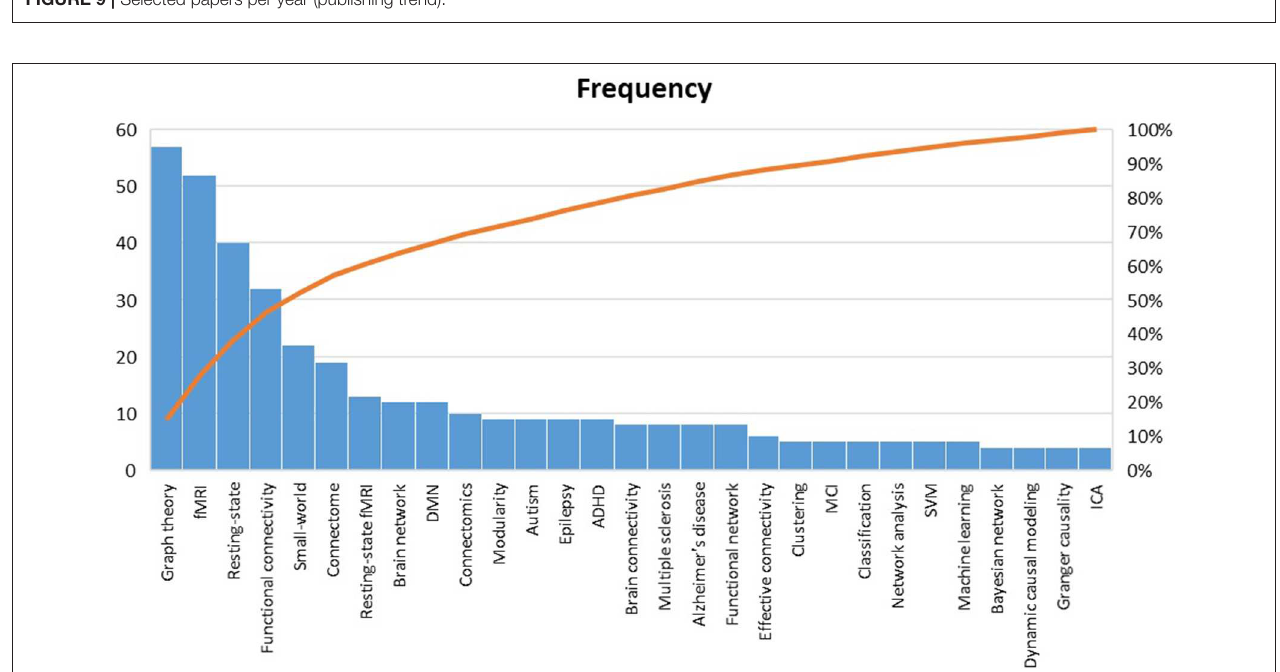
FIGURE 10 | Pareto analysis of top keywords. fMRI, Functional magnetic resonance imaging; DMN, default mode network; ADHD, Attention-deficit/hyperactivity disorder; MCI, Mild cognitive impairment; SVM, Support vector machine; ICA independent component